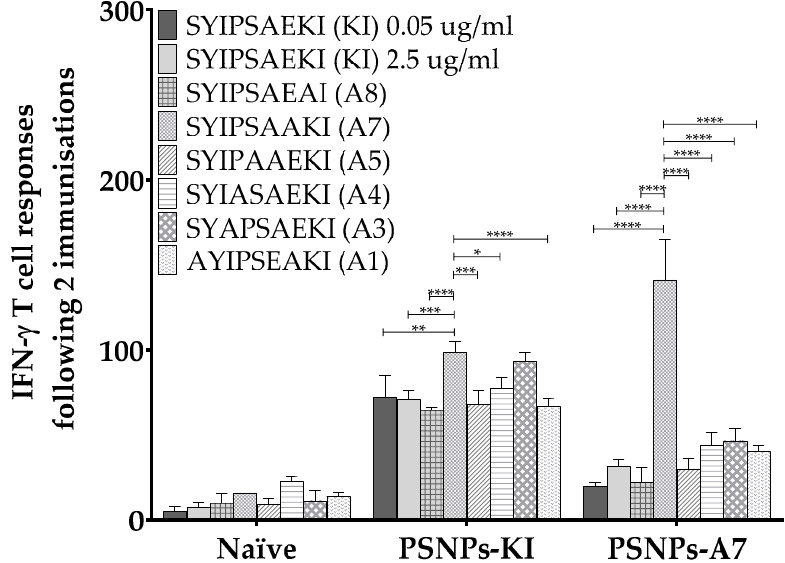
Figure 5. No evidence of antagonistic responses for KI restimulated together with alanine altered peptide variants in vitro. The 6–8 week old BALB/c mice were immunized twice with PBS alone or KI or A7 conjugated to PSNPs (25 µg per mouse KI and 0.72–0.92% solids PSNPs for both groups). Thirteen days after the last immunization, splenocytes from immunized mice were harvested and ~16 hours in an in vitro ELISpot assay for IFN- γ . Data shown as mean +/ − SD of SFU/million cells per